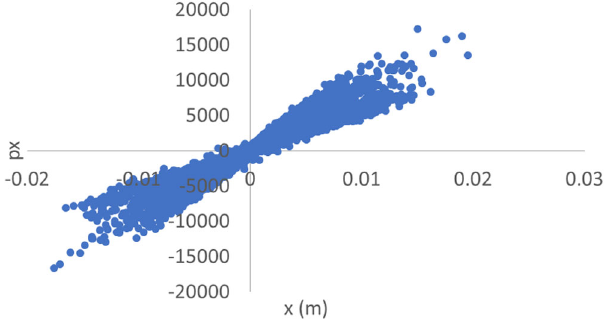
FIG. 14. Transverse phase space of the beam 75 cm down- stream from the